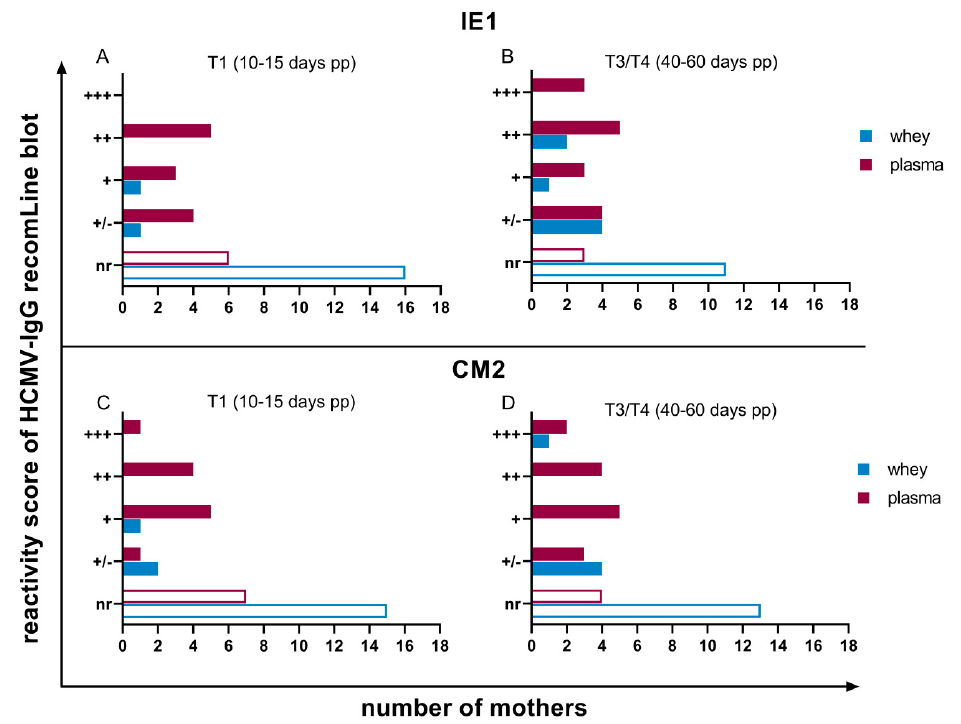
Figure 3. Reactivity scores of IgG recomLine blots for anti-recIE1-IgG at ( A ) T1 (10 to 15 days pp) and ( B ) T3 / T4 (40 to 60 days pp) and anti-recCM2-IgG at ( C ) T1 (10 to 15 days pp) and ( D ) T3 / T4 (40 to 60 days pp). The X-axis shows the number of study participants. Nr: non-reactive, +/ -: lower as cut-o ff , but detectable, + : one-fold, ++ : two-fold, +++ : three-fold stronger than cut-o ff reactivity. Breast